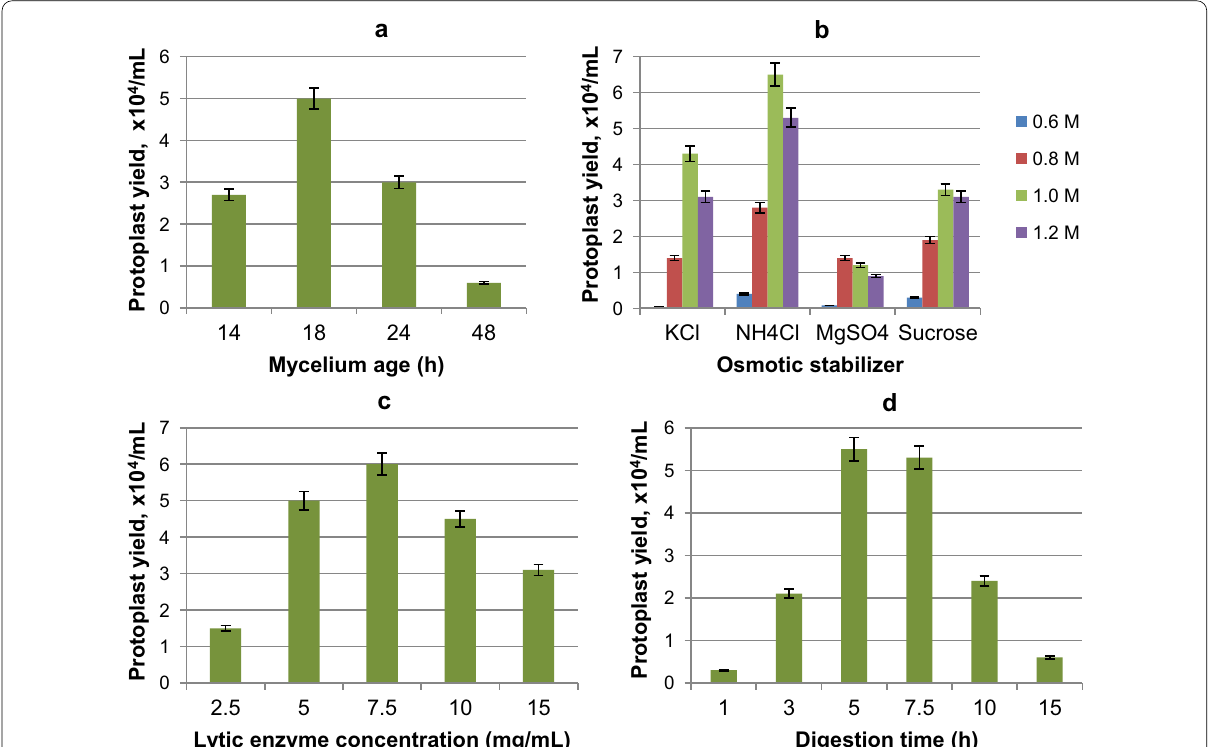
Fig. 2 Influence of mycelium age ( a ), osmotic stabilizers ( b ), concentration of the lytic enzymes complex from T. harzianum ( c ) and digestion time ( d ) on G. zeae protoplast